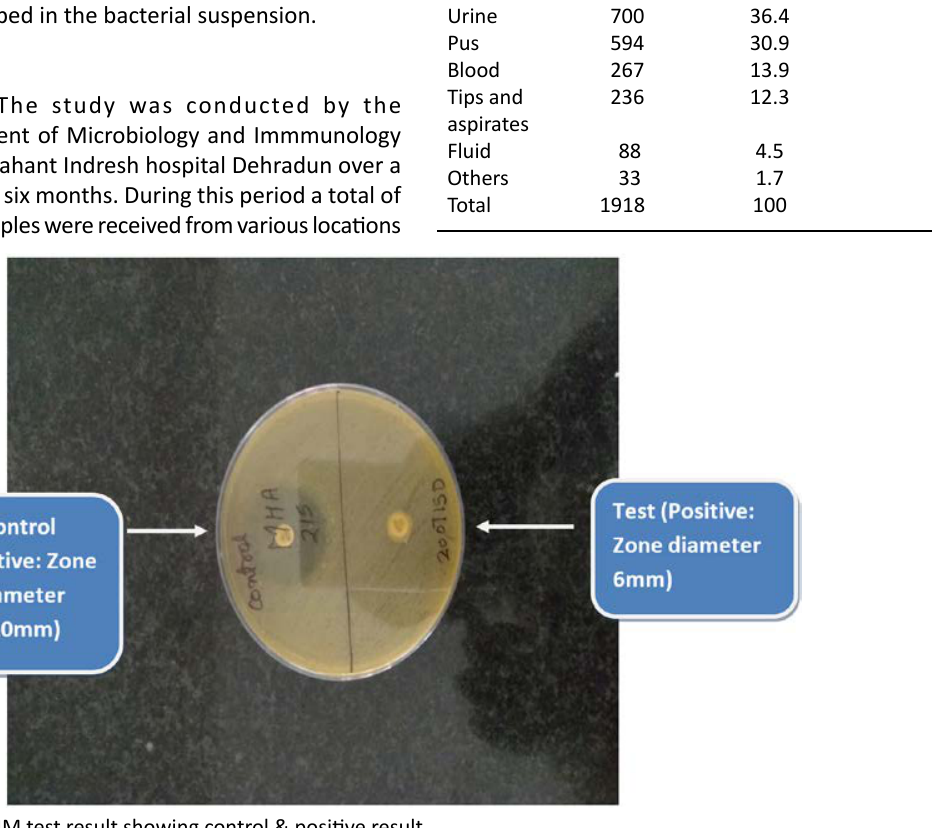
Fig. 1. mCIM test result showing control & positive